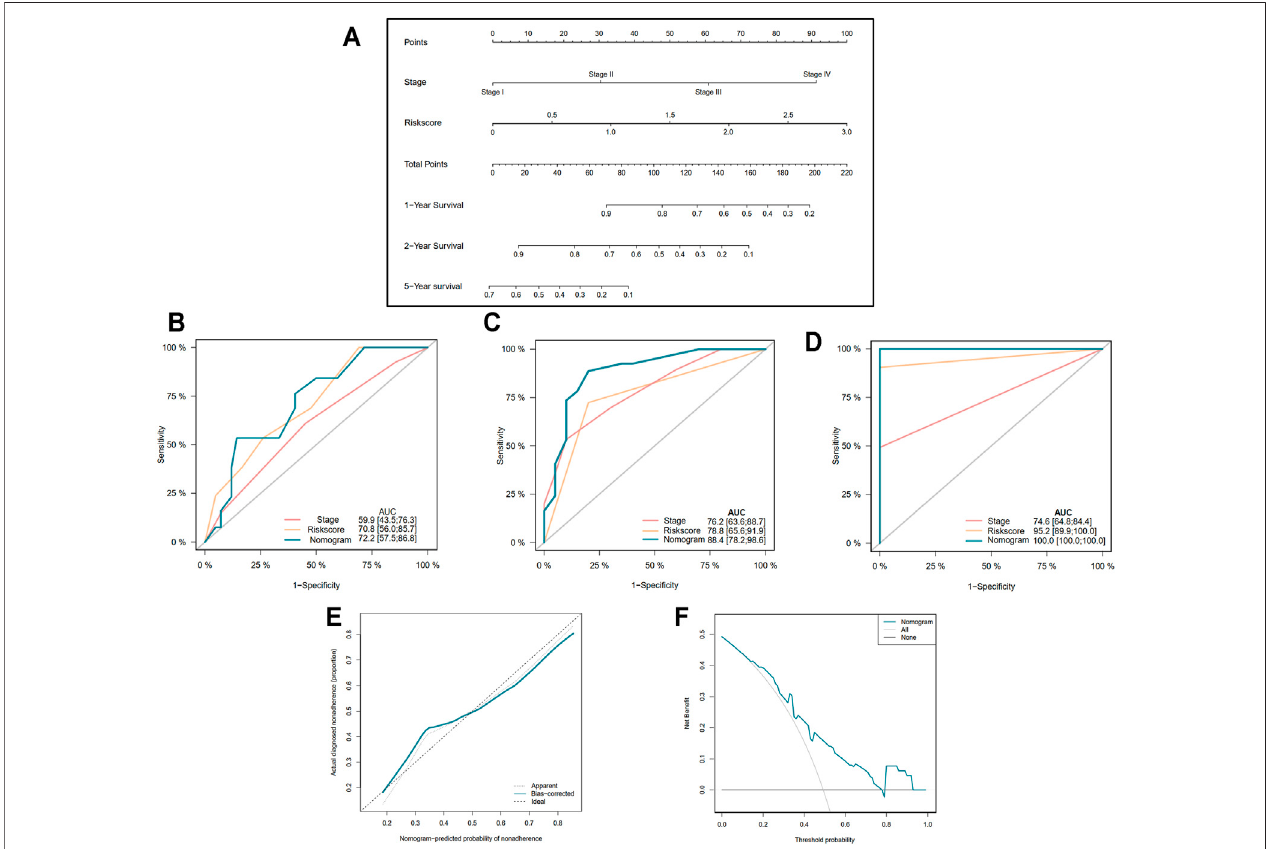
FIGURE 5 | Construction of nomogram based on the pyroptosis-related fi ve-gene signature. (A) Nomogram for predicting 1-, 2-, and 5-year survival of EAC patients. (B – D) Receiver operating characteristic (ROC) curve evaluating the ef fi ciency of nomogram for 1-, 2-, and 5-year survival of patients. (E) Calibration curve of nomogram. (F) Decision curve analysis (DCA) curve of the